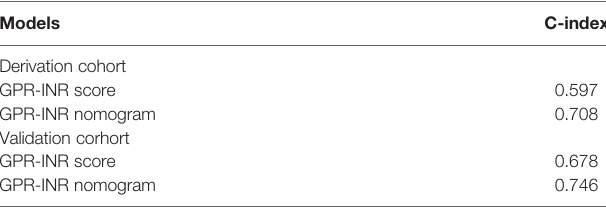
TABLE 3 | Comparisons of the values of two models in predicting prognosis of overall survivals among the patients in derivation and validation cohort.